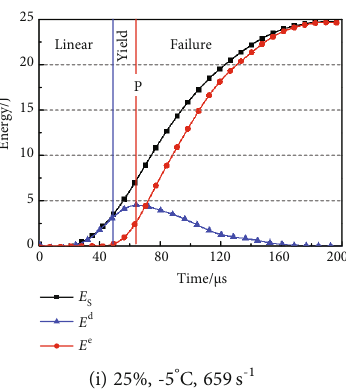
Figure 8: The energy dissipation characteristic under di ff erent deformation